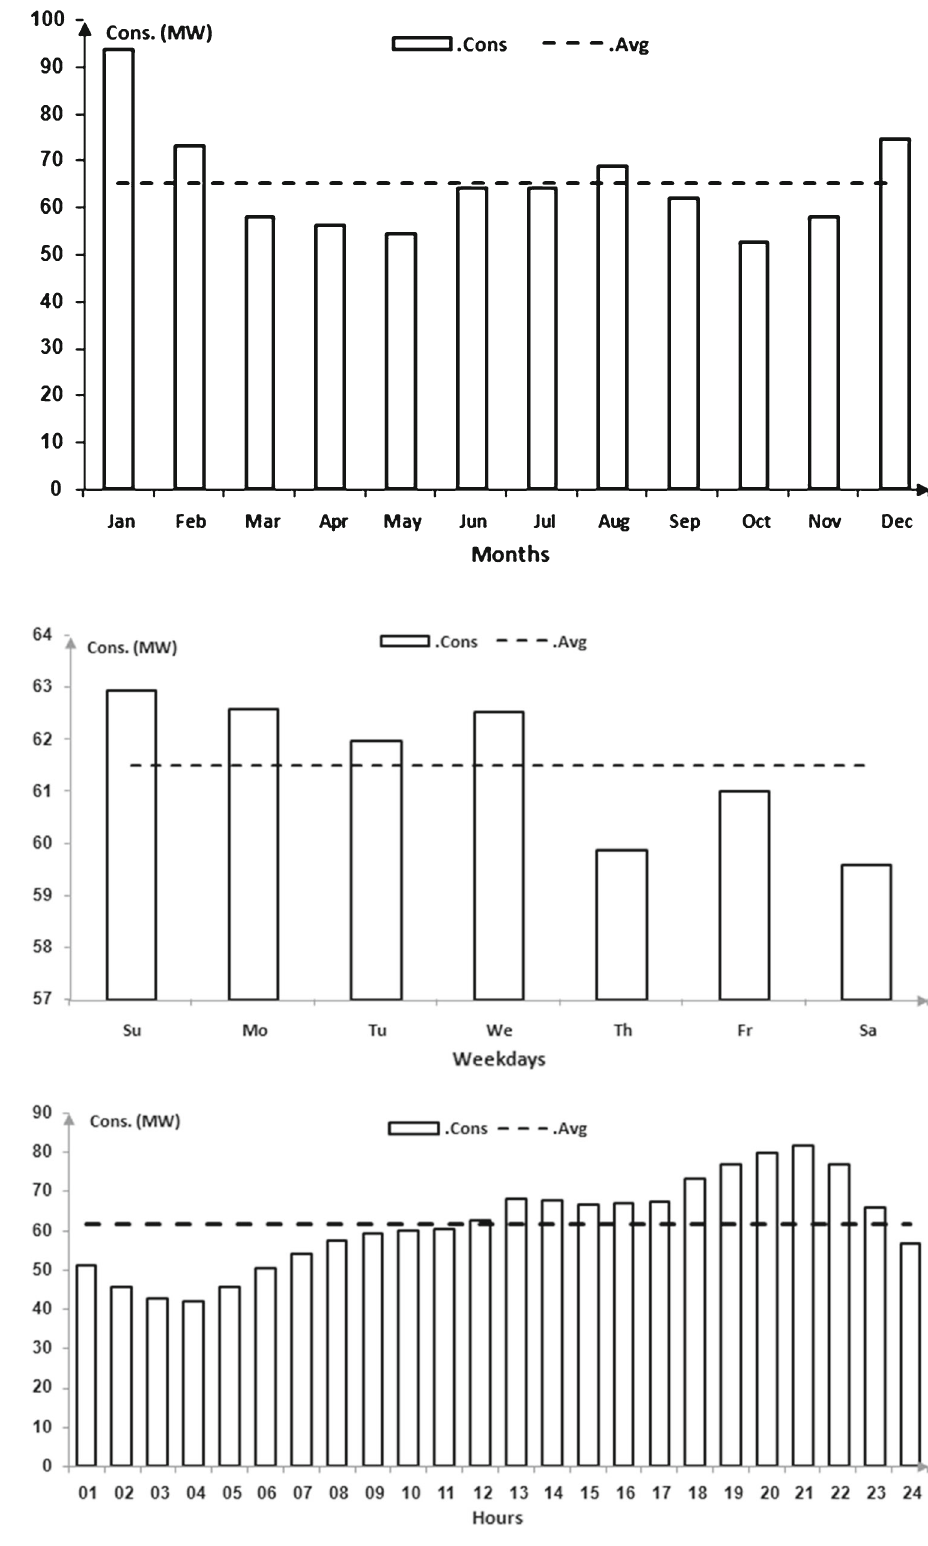
Fig. 4 Monthly consumption cycle for all meters